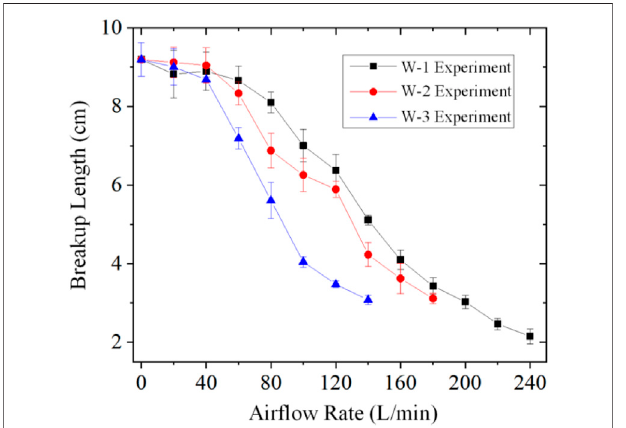
FIGURE 7 | The fl ow characteristics of the three coaxial injectors.